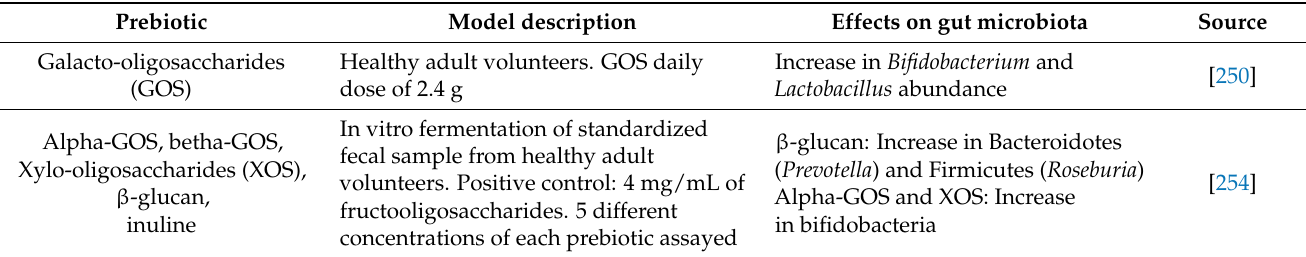
Table 2. Prebiotics and their effects on gut